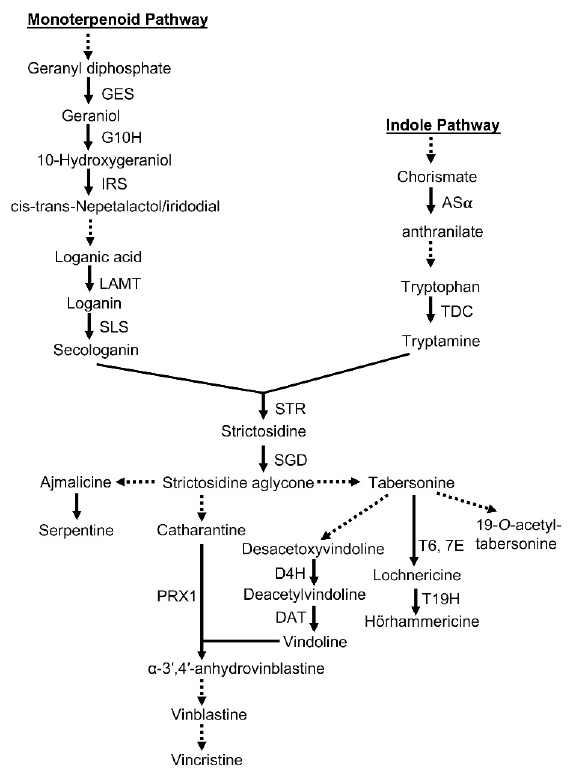
Figure 1. Terpenoid indole alkaloid (TIA) biosynthetic pathways of C. roseus . Enzyme